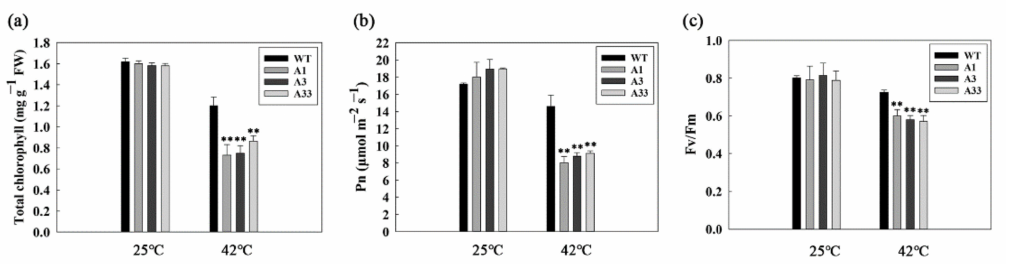
Figure 6. Content of chlorophyll ( a ), Pn ( b ), and Fv/Fm ( c ) in WT and AS lines. ** ( p < 0.01) indicate significant differences relative to the WT plants.